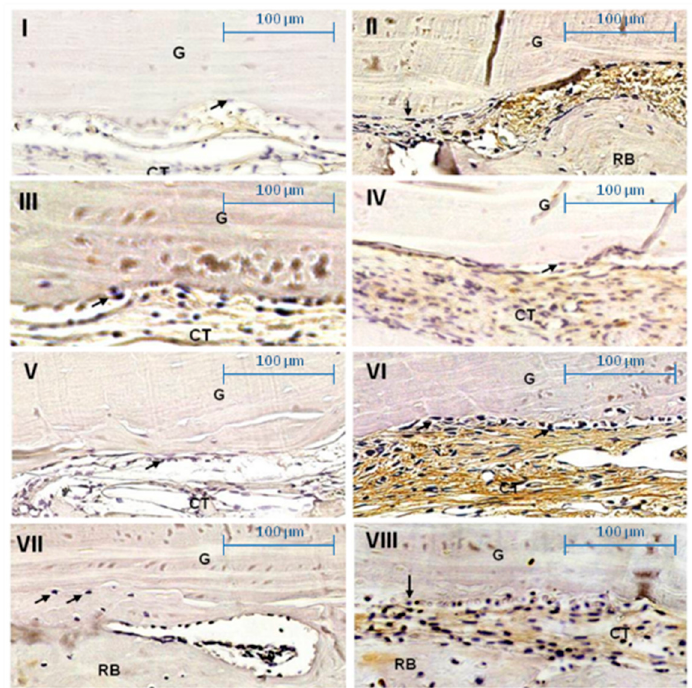
Figure 6. Photomicrographs showing the osteoblast’s OPG staining (arrows) on graft surface (G) at × 400. ( I ) Day 21 Group COM: Moderate labeling. ( II ) Day 60 Group COM: Intense labeling of osteoblasts. ( III ) Day 21 Group TOM: Mild labeling of osteoblasts. ( IV ) Day 60 Group TOM: Intense labeling of osteoblast. ( V ) Day 21 Group CS: Mild labeling of osteoblast. ( VI ) Day 60 Group CS: Intense labeling of osteoblast. ( VII ) Day 21 Group TS: Mild labeling of osteoblasts. ( VIII ) Day 60 Group TS: